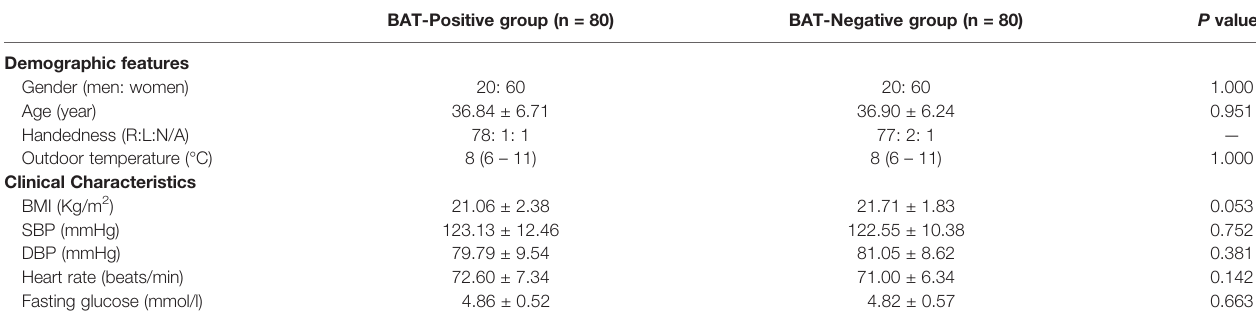
TABLE 1 | Characteristics of the subjects with activated BAT (BAT Positive) and without 18 F-FDG BAT uptake (BAT Negative)*. BAT-Positive group (n = 80) BAT-Negative group (n = 80)